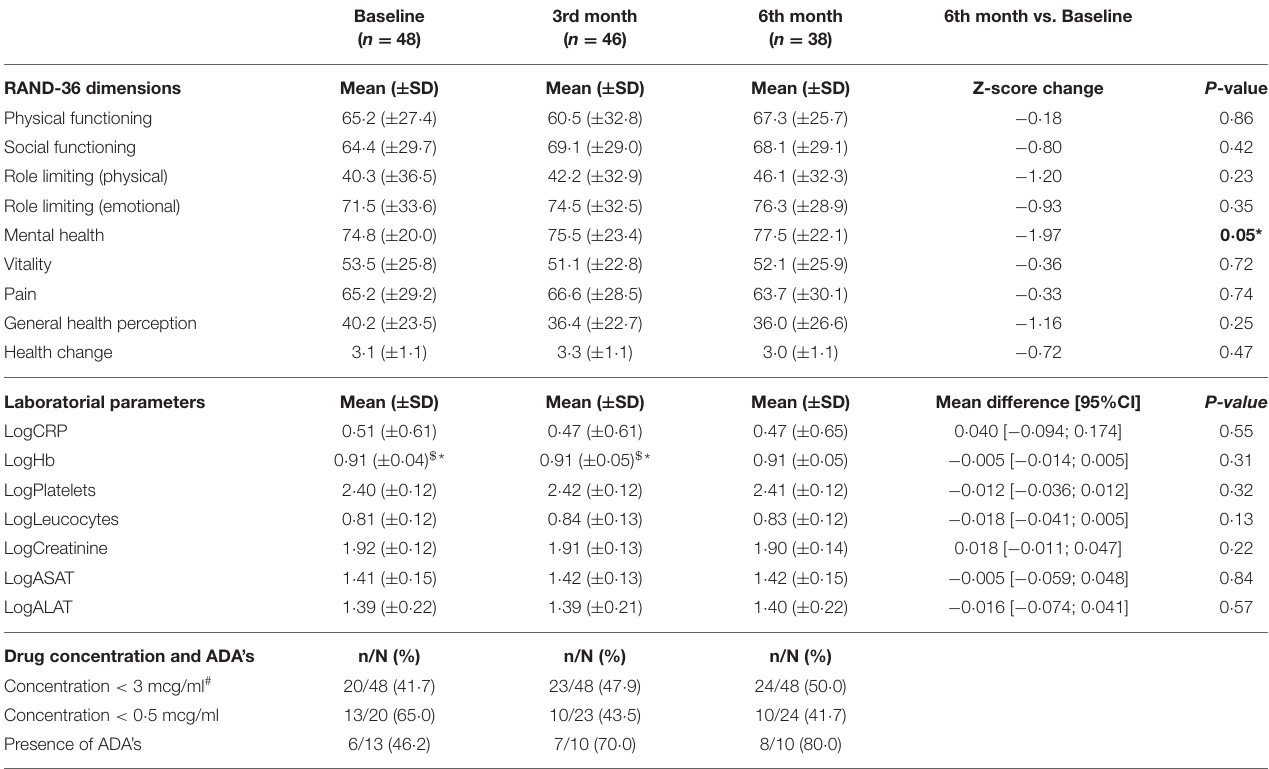
TABLE 3 | Results patient self-reported outcomes and clinical blood assessments.